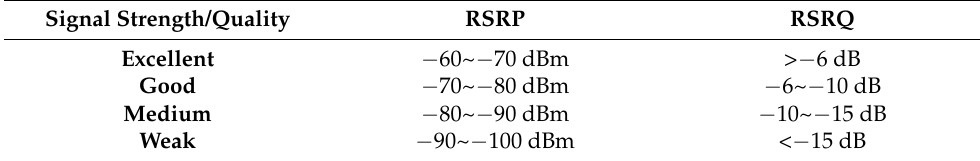
Table 3. Signal status based on RSRP and RSRQ value.